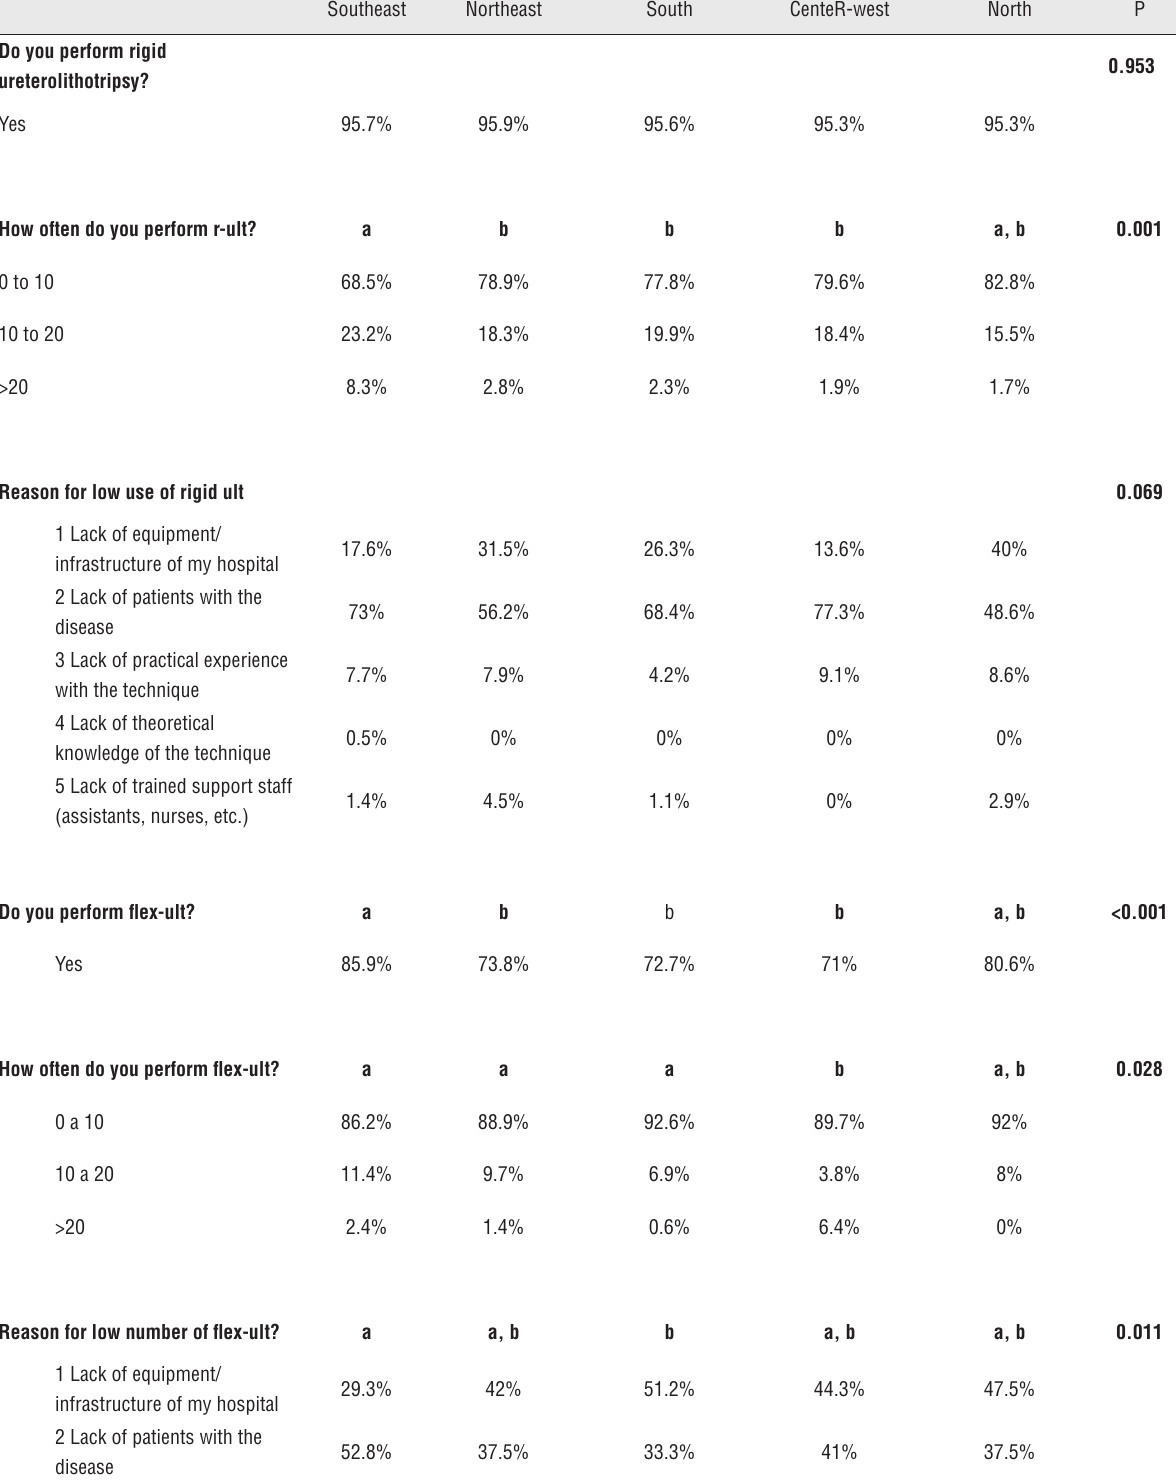
Table 2 - Answers of